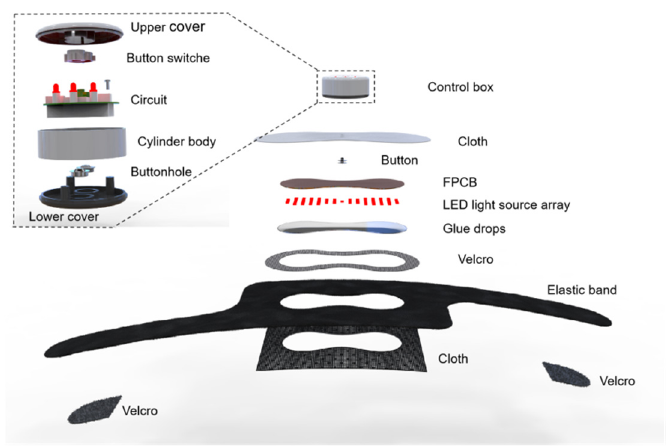
Figure 1. The 3-D model of the phototherapy device for knee OA. The control box comprises an upper cover, a cylinder body, and a lower cover. The upper cover was designed with two button switches and three LED indicators. The two button switches used mechanical elastic button switches, respectively, to achieve power switch and irradiance adjustment. The three LED indicators were associated with three brightness levels with irradiance; the greater the irradiance, the more LED indicators that light up. The cylinder body was equipped with a Type-C data interface, which